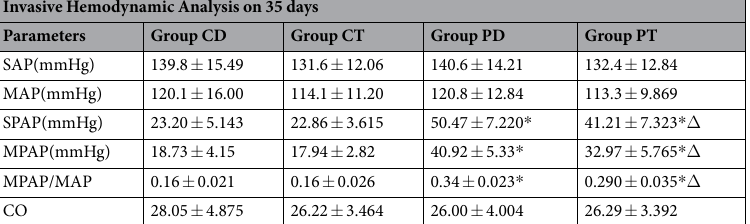
Table 4. Invasive hemodynamic analysis of rats in the PAH and control groups with or without LXR activation. n = 6, * Compare with Group CD, p < 0.05, Δ Compare with Group PD, p < 0.05.